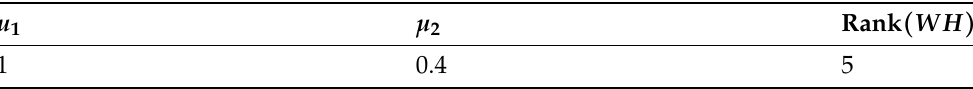
Table 3. Hyperparameters of the Windowing